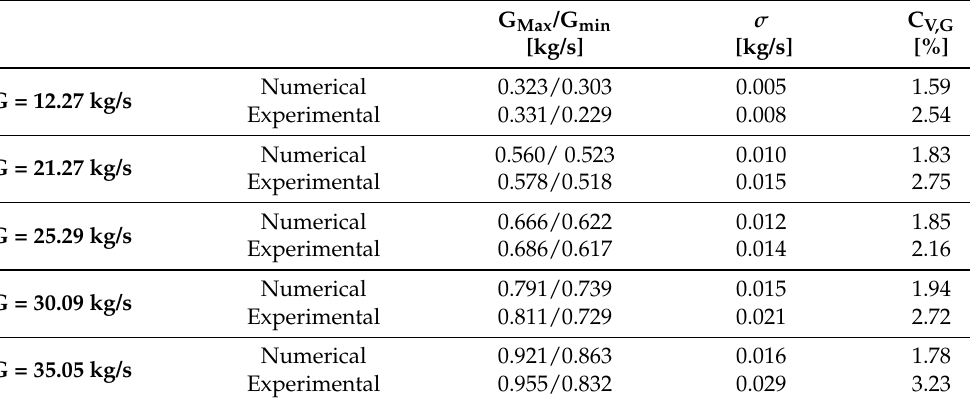
Figure 14. Comparison of OVT coolant mass flow rate distributions at G = 35.05 kg/s. Table 9. Comparison of OVT coolant mass flow rate distribution main parameters.